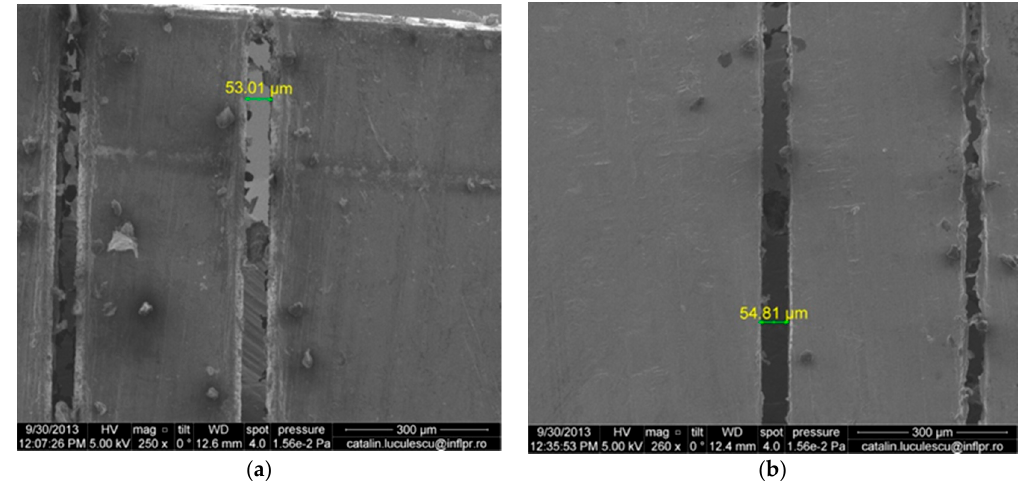
Figure 4. Slit obtained in a 400- μ m thick Al workpiece by repeated scanning the ps beam over the target at a laser repetition rate of 500 kHz. ( a ) Entrance surface; ( b ) exit surface. The width of the slit is larger at the exit than at the entrance, contrary to laser drilling in air. The other slits in the figures are obtained with a higher scanning speed of 50 mm/s.